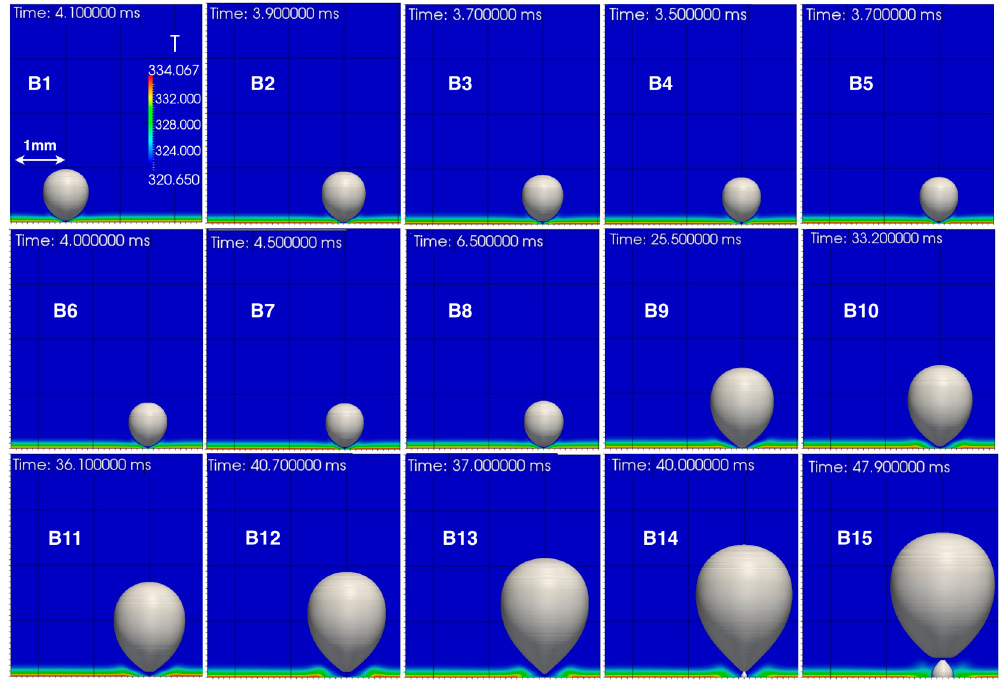
Figure 14. Spatial evolution of generated bubble at the time of detachment for each R113 case of the Series B parametric numerical simulations.